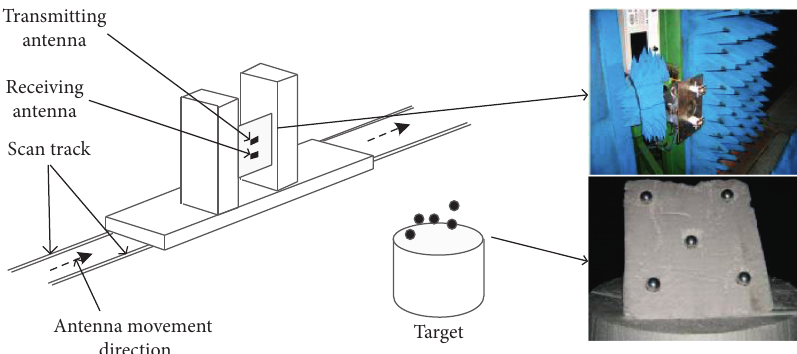
Figure 12: Microwave anechoic chamber test system